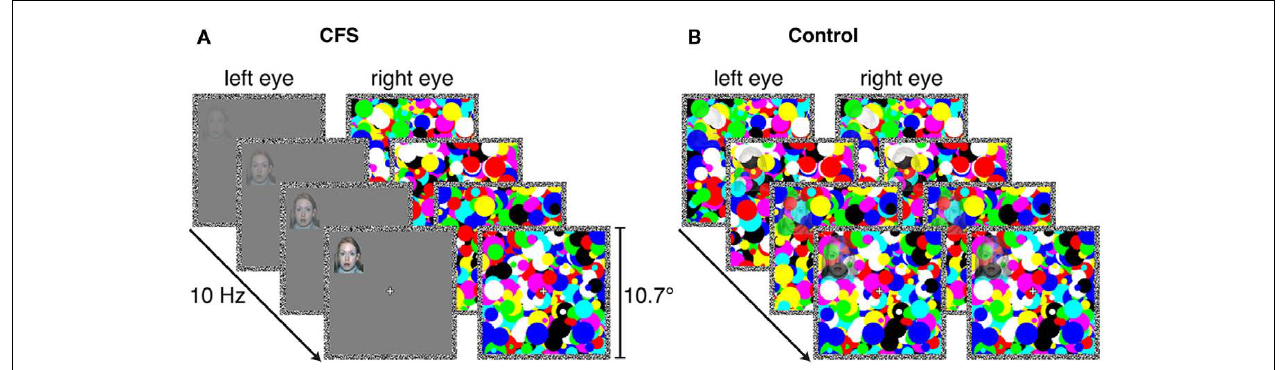
localization task as in Experiments 1 and 2. In Experiment 6, display presentation durations were fixed and the localization task was unspeeded, as in Experiment 3.